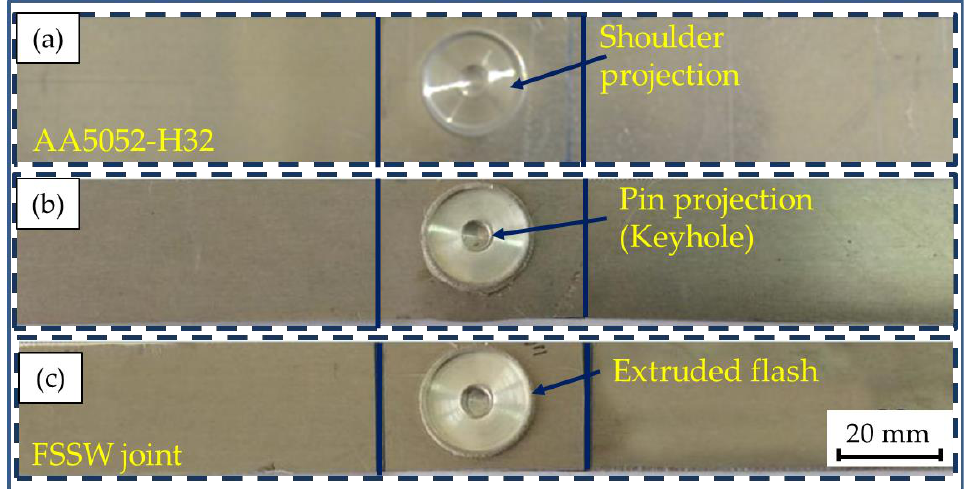
Figure 4. The visual appearance of the AA5052-H32 FSSWed lap joints processed at 500 rpm rotation rate and various dwell times of ( a ) 1, ( b ) 2, and ( c ) 3 s.